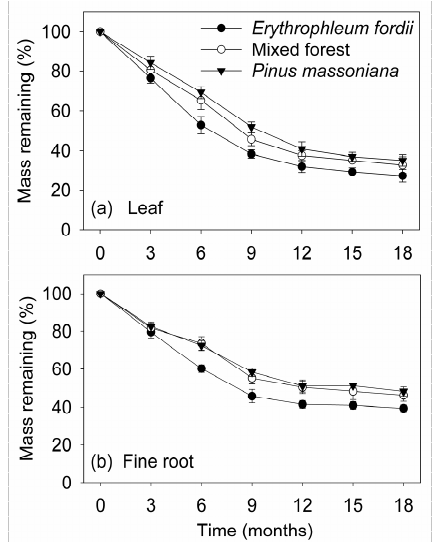
Figure 1. Average percent of leaf and fine root litter original remaining mass (mean ± standard error, n = 3) of three subtropical plantations in China.